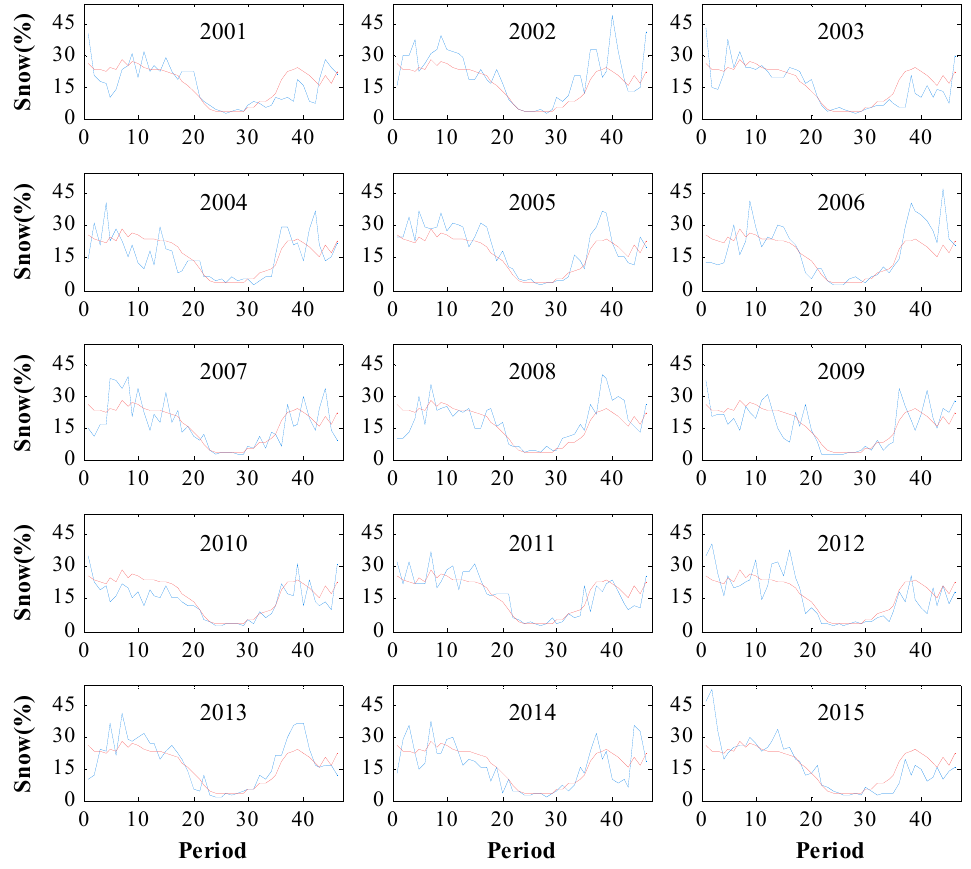
Figure 3. Seasonal variation of snow cover derived from MODIS eight-day snow products during 2001–2015. X-axis: serial number of the eight-day period of the year. Y-axis: percentage of Tibetan area covered by snow. Curves represent each individual year (blue) and the average year (red).